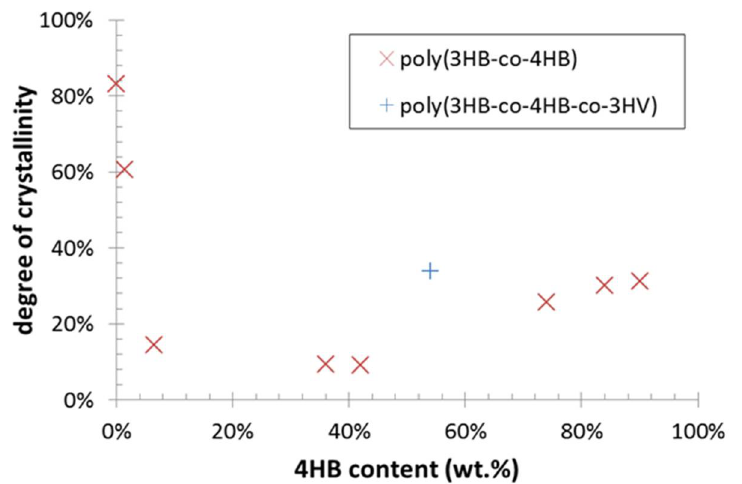
Figure 4. Degree of crystallinity of PHA films estimated from DSC analysis.